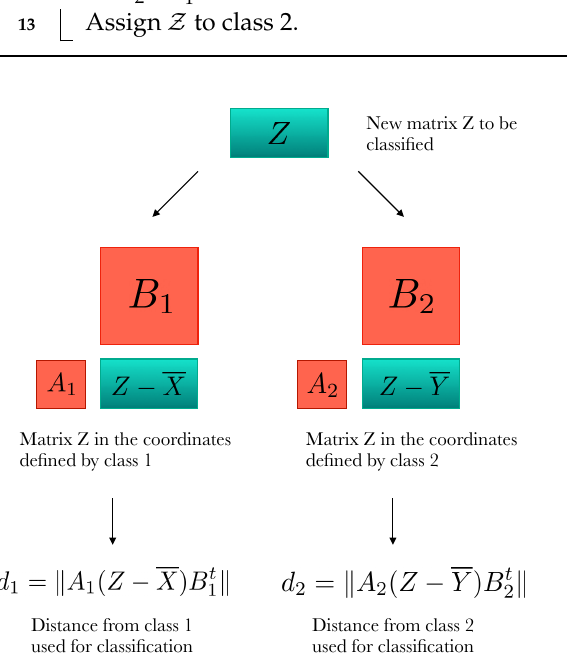
Figure 2. Graphical representation of Algorithm 2 in the case of matrix